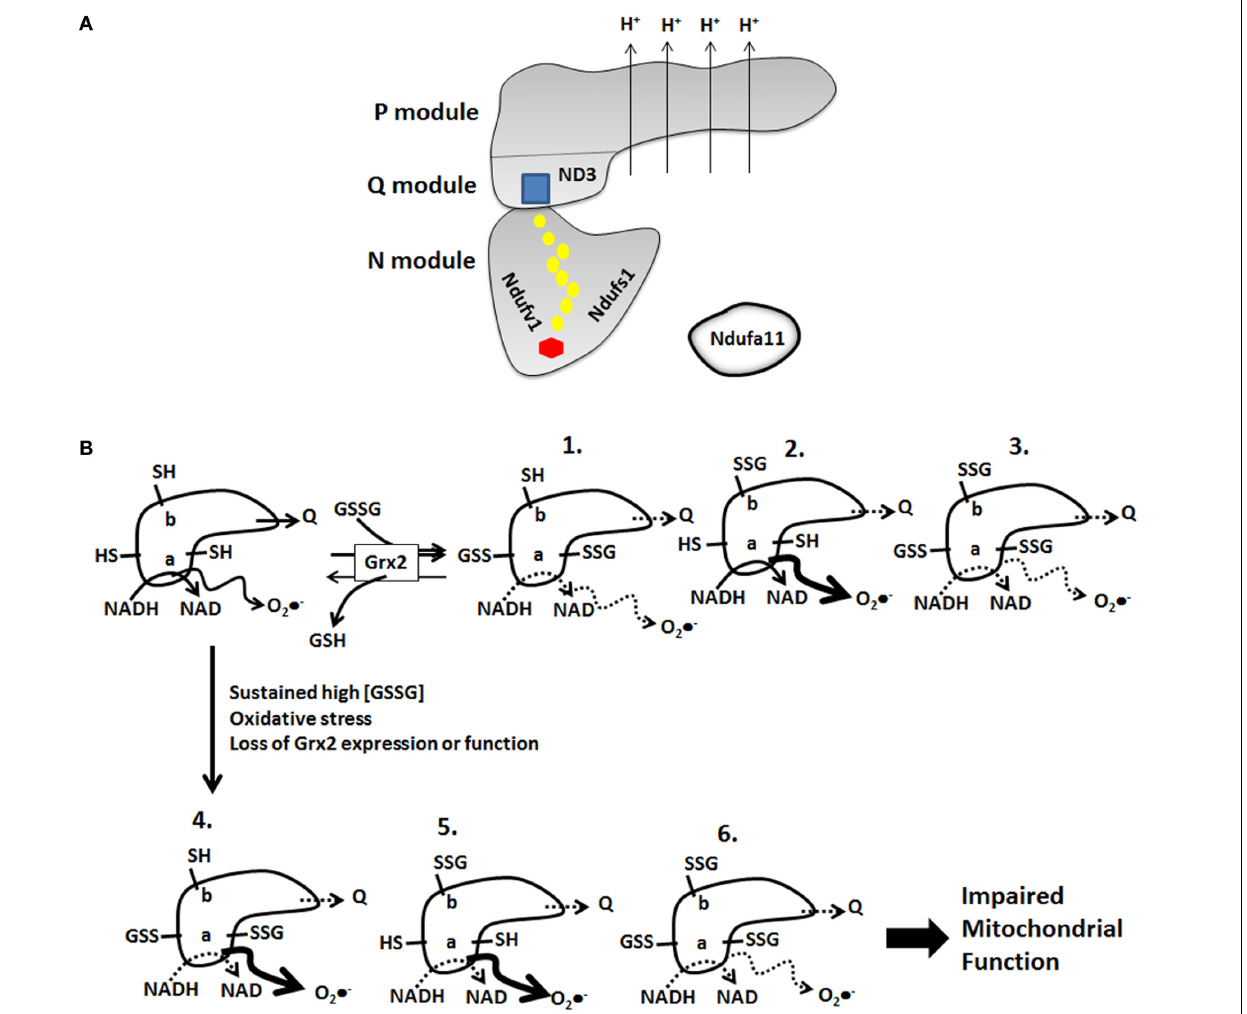
FIGURE 3 | Complex I harbors multiple S-glutathionylation sites which may serve as a “cysteine code” required to modulate its activity under various conditions. (A) Representative diagram illustrating the basic structure of Complex I and the location of the various modules, prosthetic groups, and proton pumping domains. Subunits that can be S-glutathionylated are highlighted. Hexagon; FMN, circles; Fe-S clusters, square; ubiquinone binding site. (B) Complex I cysteine code. Hypothetical schematic depicting the different possible S-glutathionylation states that can